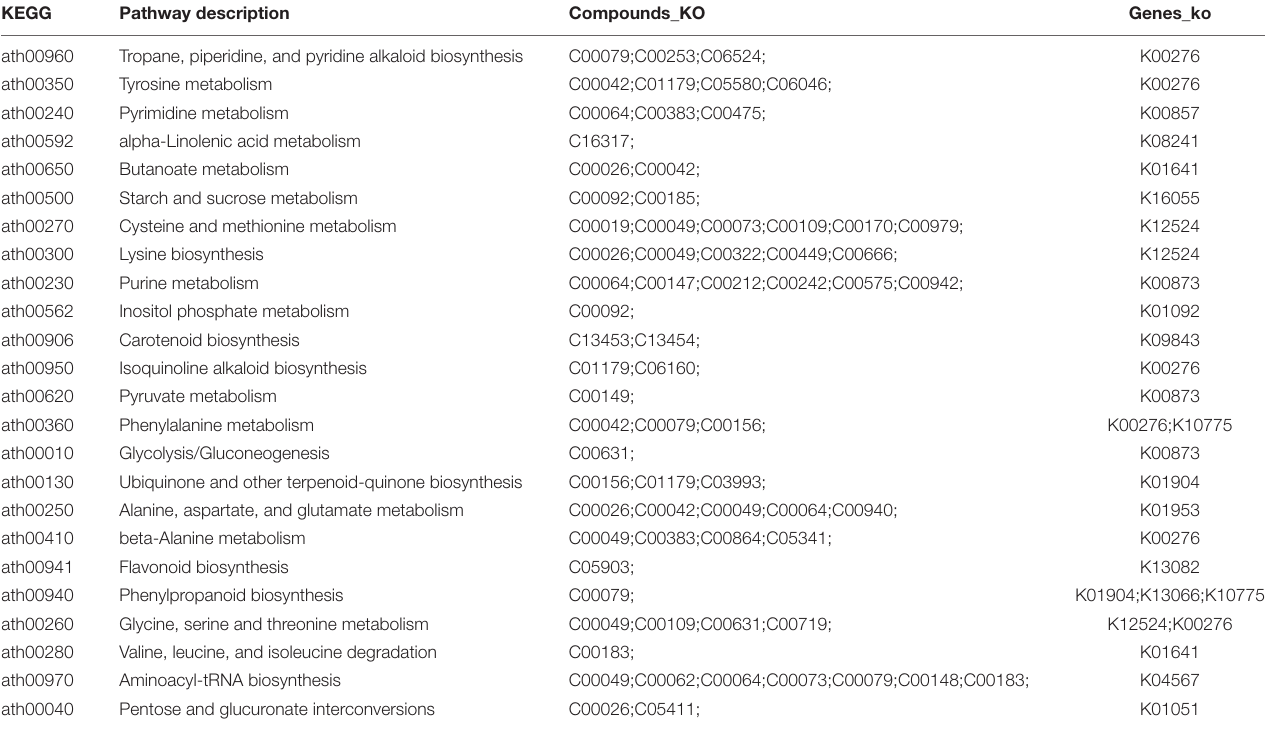
TABLE 2 | Results of integrative analysis of transcriptome and metabolome.